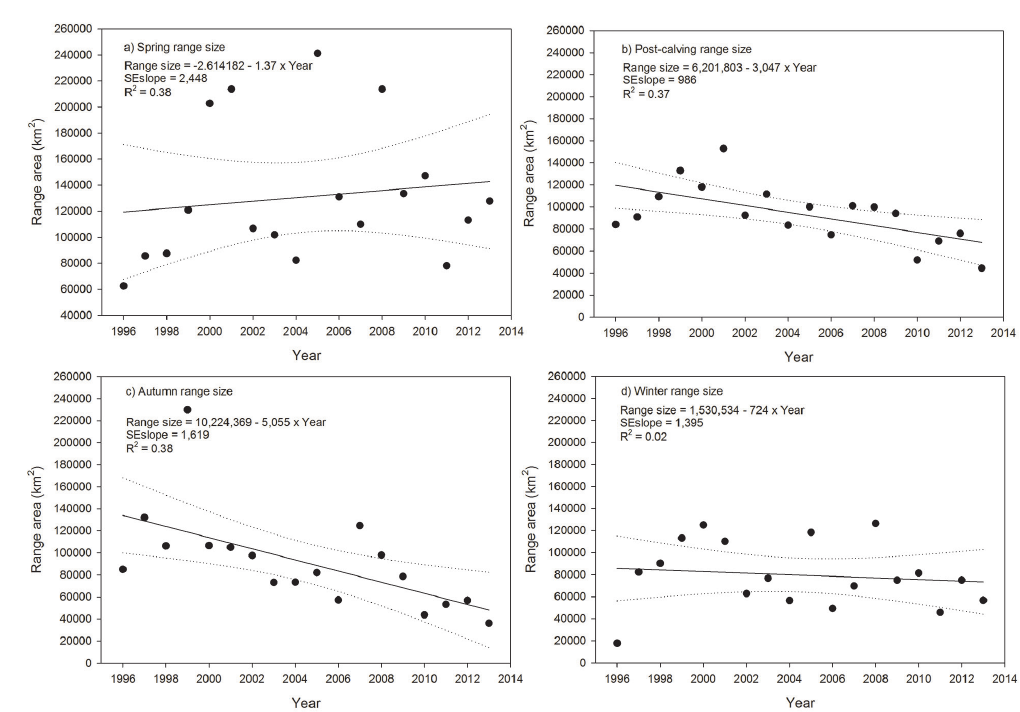
Figure 3. Trends (red lines) and 95% confidence intervals (blue lines) in 95% kernel range sizes (km 2 ) of the Ba- thurst caribou herd for (a) spring, (b) post-calving, (c) autumn and (d)